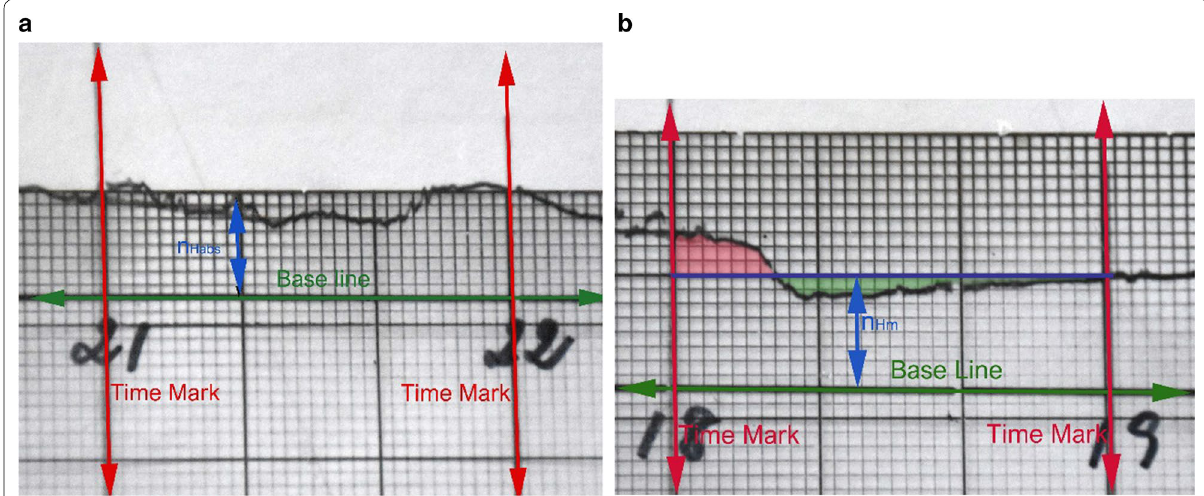
Fig. 15 Measurement of ordinates by means of a glass scale. a Scale adjusted for measuring the ordinate at a discrete time (21 h 19 min, 7.9 mm). b Scale adjusted for measuring the hourly mean (18–19 h, 8.1